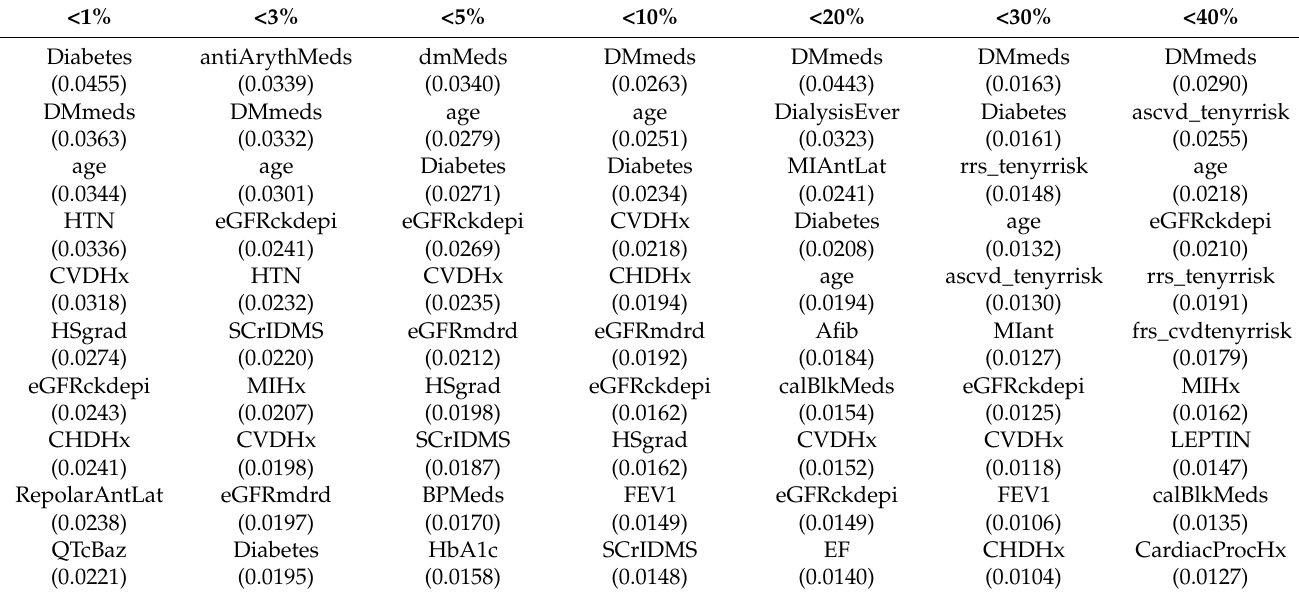
Table 5. The selected parameters of the final HF prediction model for XGBoost using MissForest